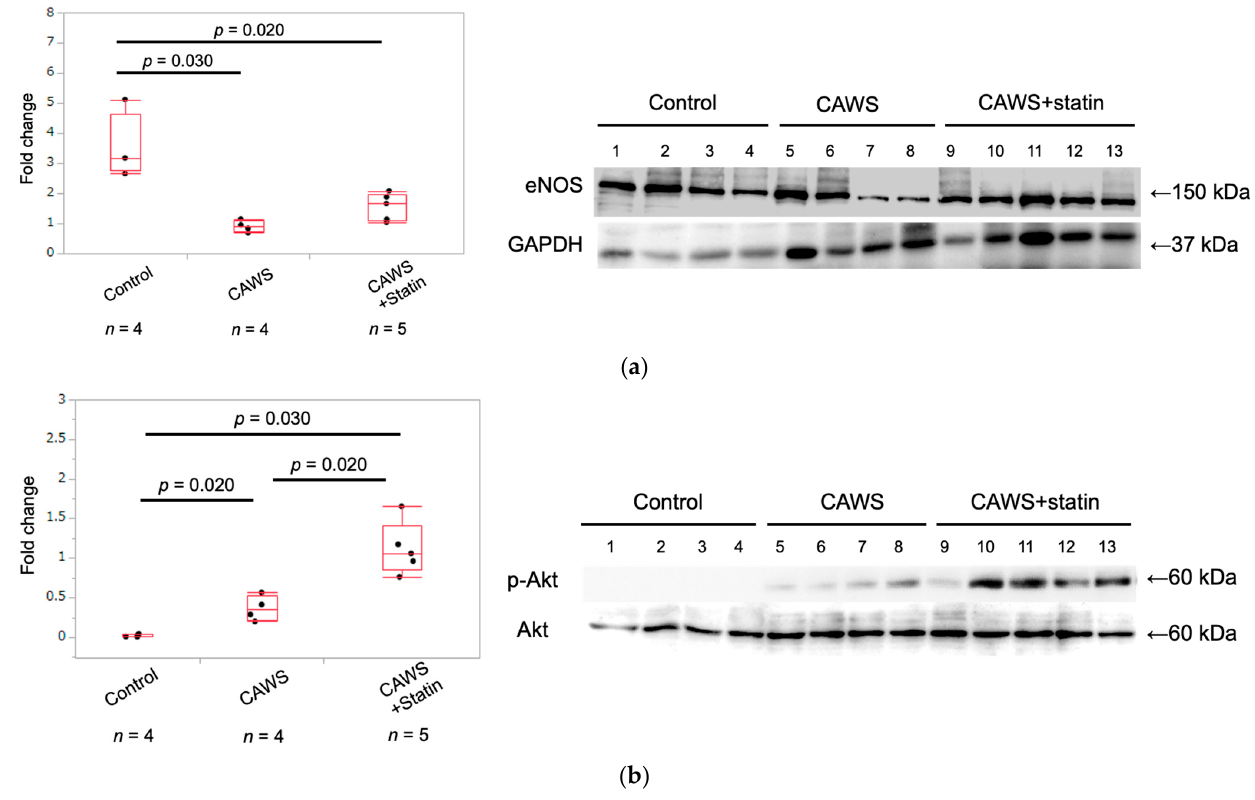
Figure 2. Expression of eNOS, phospho-Akt, and Akt proteins in aortic tissue. ( a ) The intensity of eNOS protein expression was normalized to that of glyceraldehyde 3-phosphate dehydrogenase (GAPDH). eNOS expression was significantly higher in the control group than in the CAWS and CAWS+statin groups. The CAWS+statin group had higher but non-significant eNOS expression compared with the CAWS group. ( b ) Akt expression was significantly higher in the CAWS and CAWS+statin groups compared with the control group. Comparison of the CAWS and CAWS+statin group showed higher Akt expression in the CAWS+statin group.